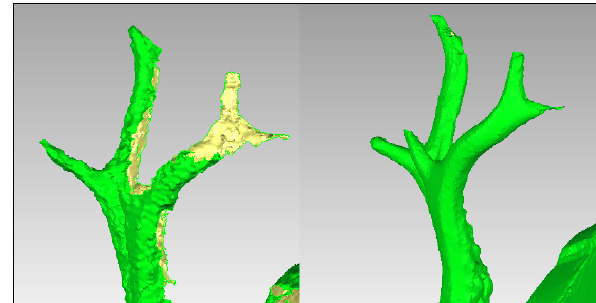
Figure 4. Holes on the models of the DAVID (left) and the ARTEC MH (right)